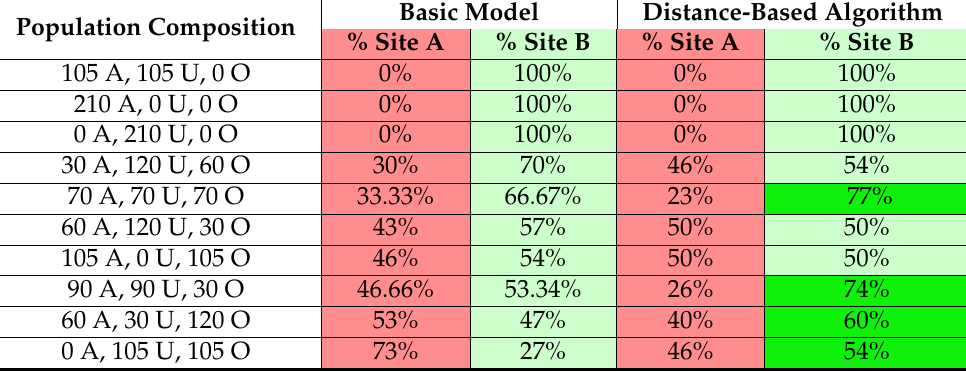
Table 3. Comparing the accuracy of consensus accuracy when using the basic behavioral model vs. the distance-based algorithm for different swarm compositions. Errors in measurements can occur only at site A (red). Population